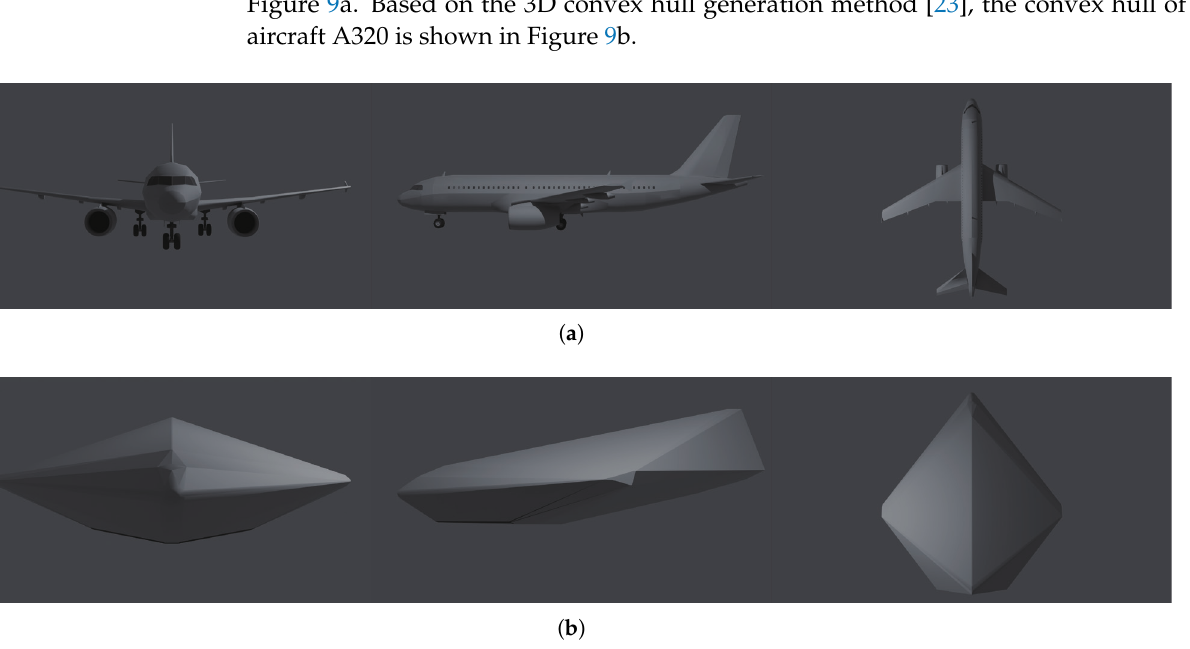
Figure 9. Three views of the three-dimensional (3D) model and convex hull of the aircraft A320. ( a ) Three views of the 3D model of the aircraft A320. ( b ) Three views of the 3D convex hull of the aircraft A320 based on 3D